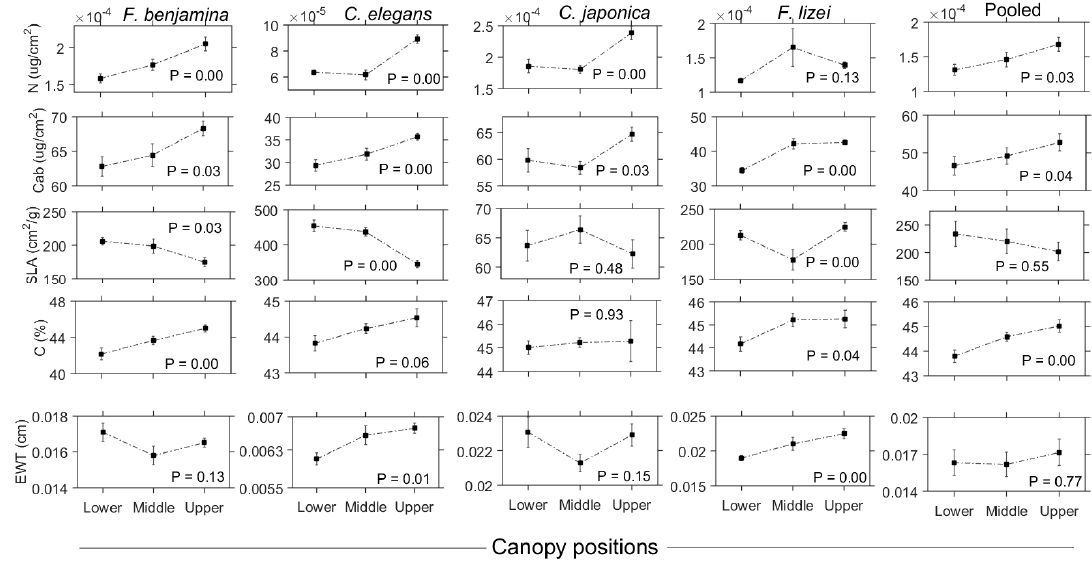
Figure 6. Graphical matrix showing variation in leaf functional traits across the vertical canopy profile for the studied species as well as for the pooled dataset (fifth column). Error bars represent standard errors.